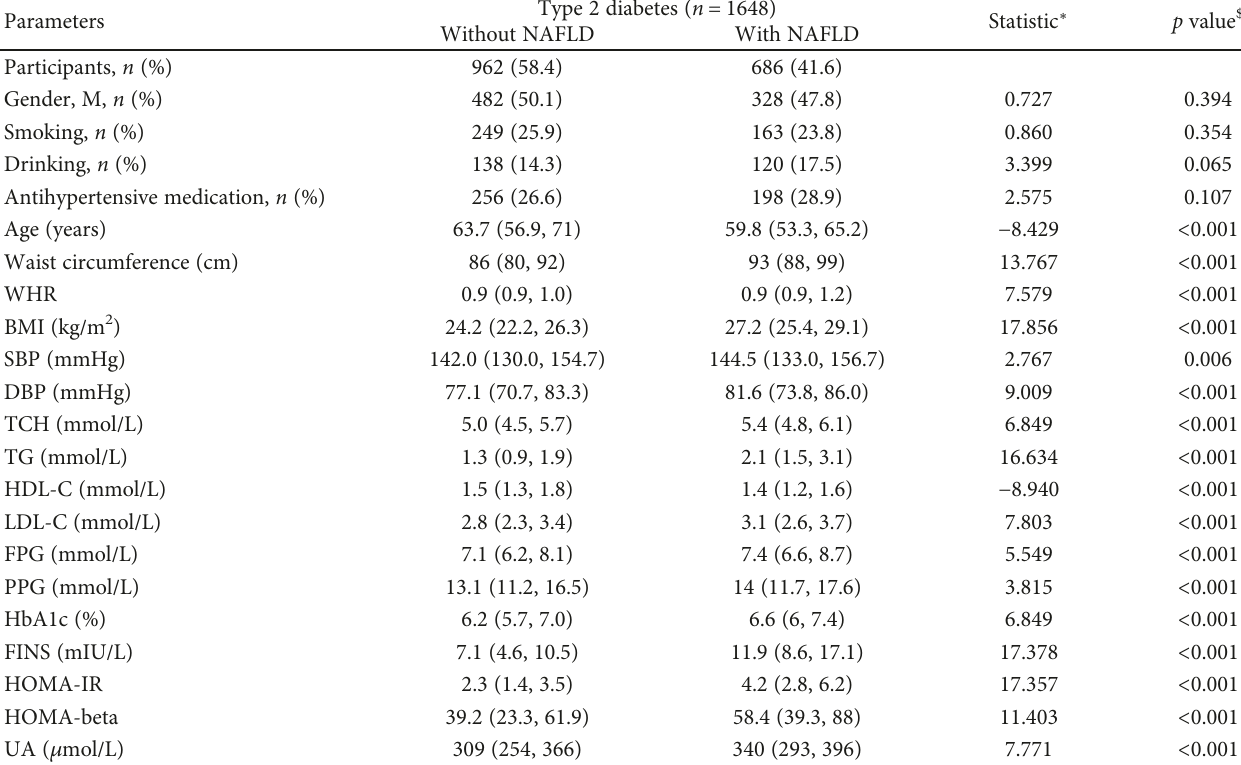
Table 2: General demographic and metabolic characteristics of type 2 diabetes, grouped according to with or without NAFLD.